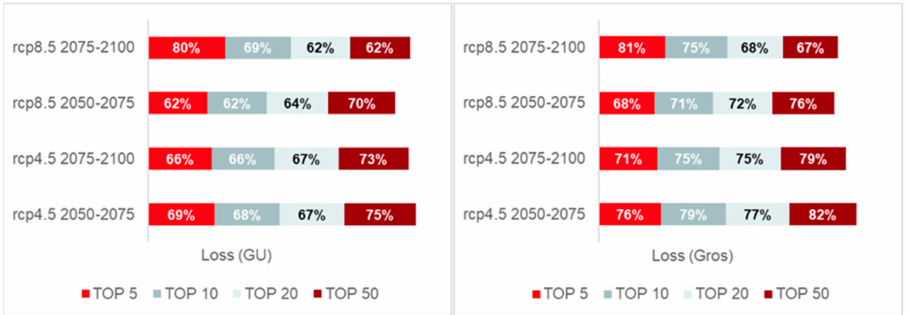
Figure 9. Relative comparison of the sum of the top losses on the market portfolio per climate scenario without adaptation, in comparison with the reference period: left —GU loss, right —Gross